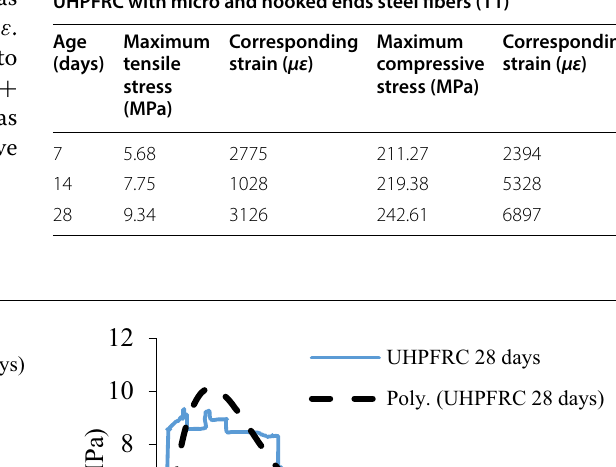
Table 3 Tensile and compressive stress–strain values with modulus of elasticity for UHPFRC (T1) at different